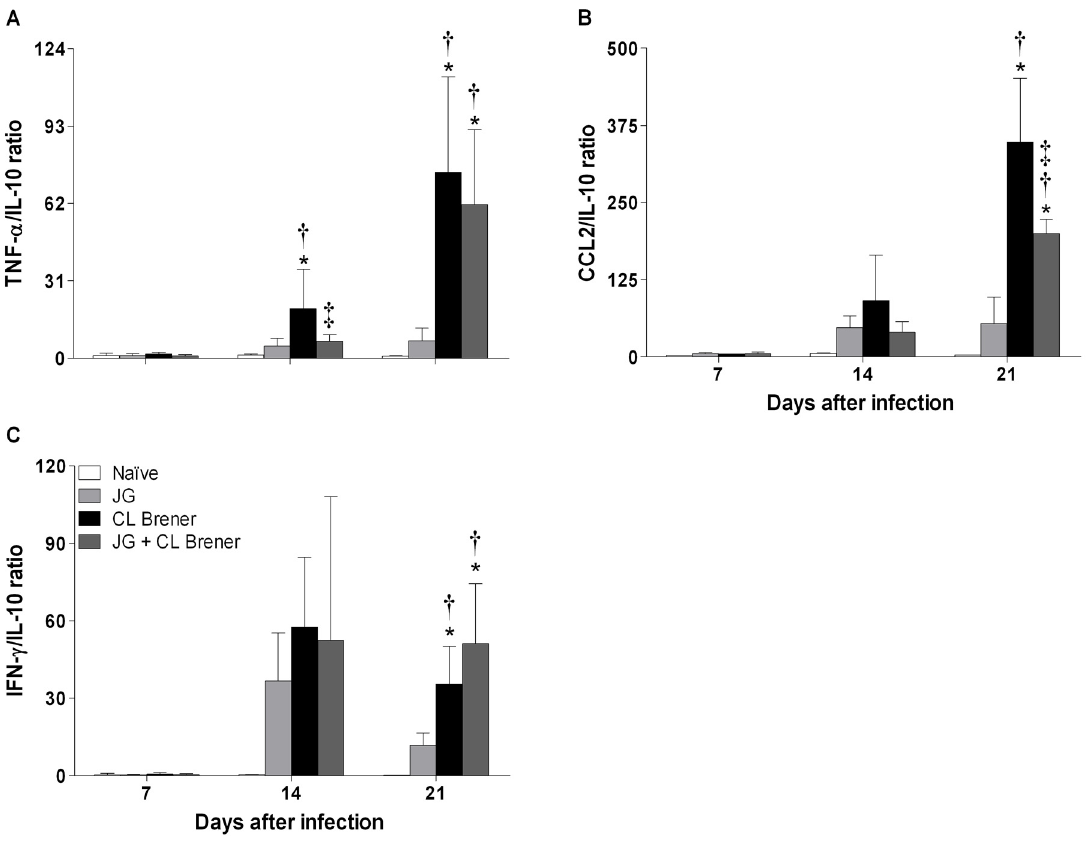
Figure 6. Serum TNF- a , CCL2 or IFN- c to serum IL-10 ratios in BALB/c mice infected with JG and/or CL Brener. Groups of mice were infected with 100 trypomastigotes of JG or CL Brener (single infection) or coinfected with 100 trypomastigotes of both T. cruzi populations in a 1:1 ratio via the intraperitoneal route, and TNF- a /, CCL2 or IFN- c to serum IL-10 ratios were assessed at 7, 14 and 21 days p.i. Symbols as follows: (A) TNF- a /IL-10; (B) CCL2/IL-10; (C) IFN- c /IL-10; white bar: Naı¨ve mice; light gray bar: JG infected mice; black bar: CL Brener infected mice; and dark gray bar: JG and CL Brener infected mice. Values are expressed as the mean 6 SEM of three mice per group (representative of two independent experiments). *, { and { represent P , 0.05 when compared with naı¨ve, JG and CL Brener mouse groups, respectively.